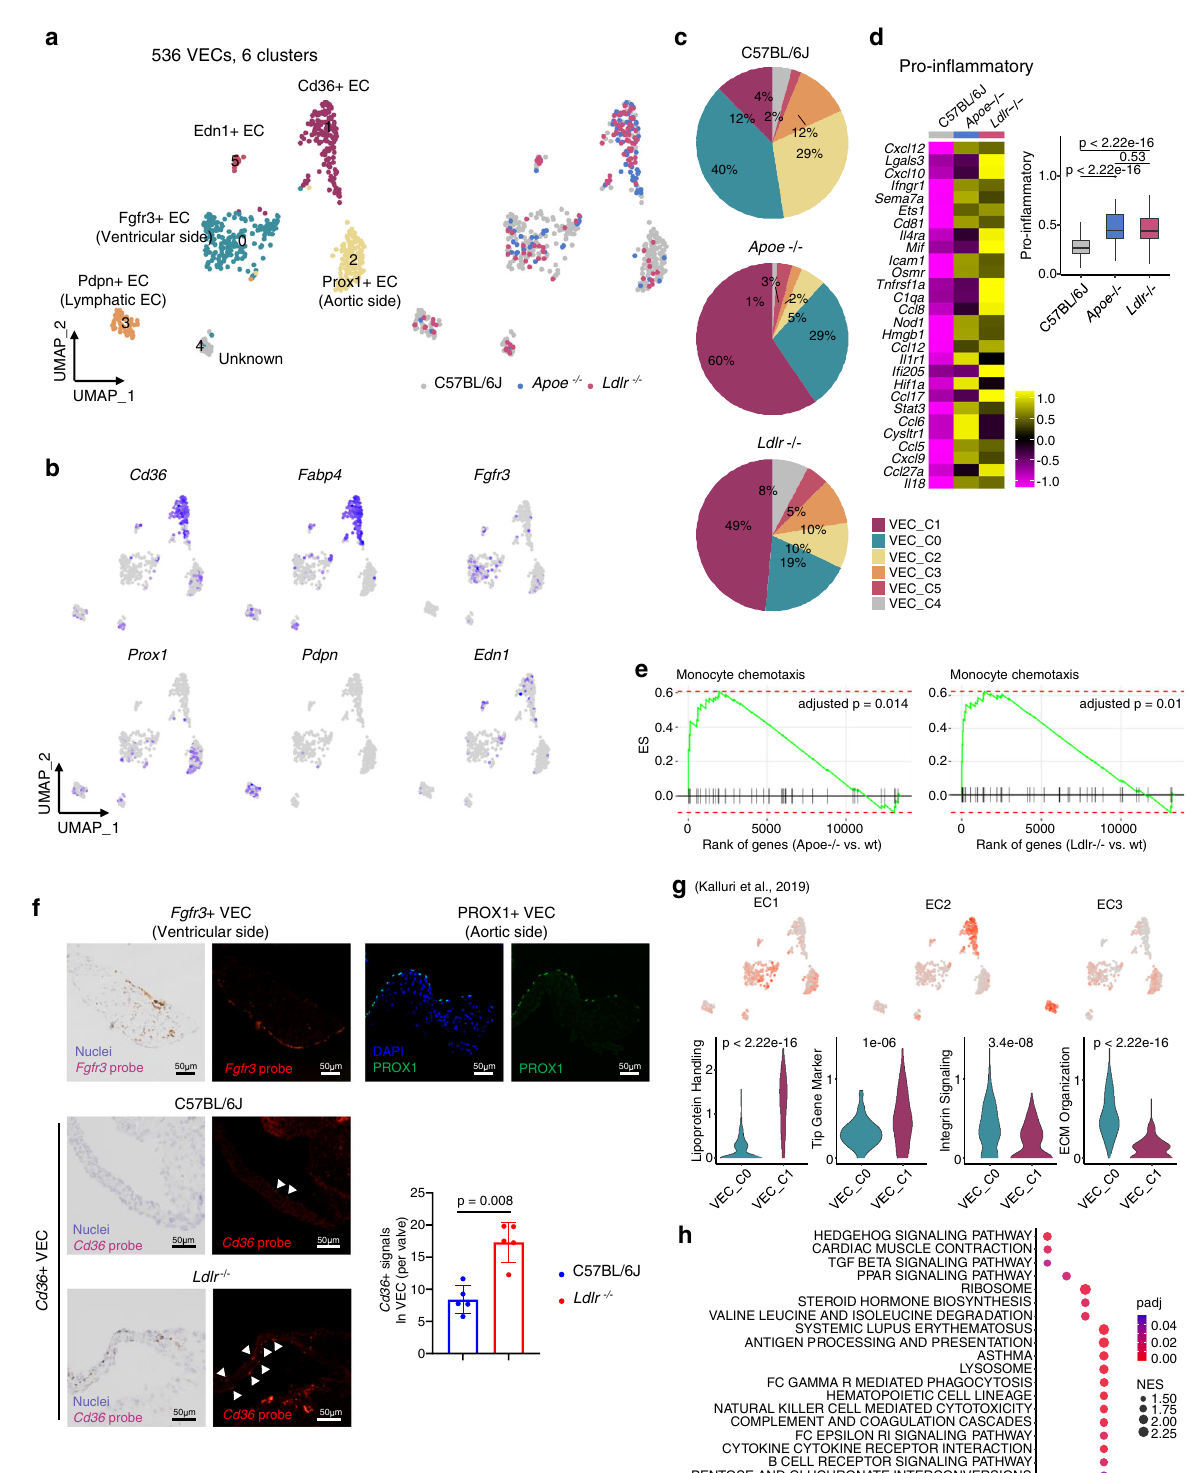
Supplementary Table 1 for the clinical information of patients. For human aortic VEC isolation, human aortic valves from two patients were provided by The Catholic University of Korea, Uijeongbu St.